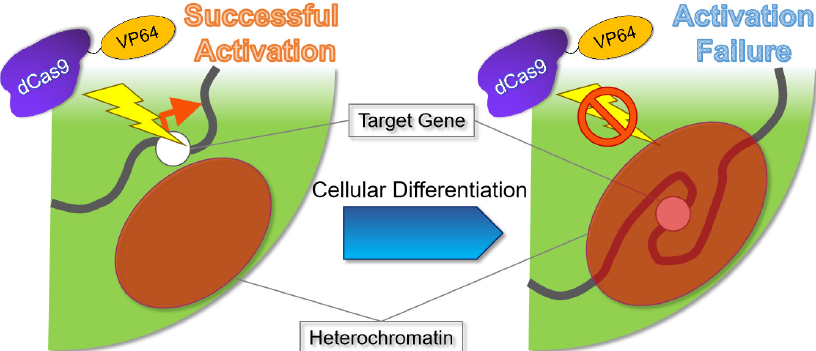
Figure 3. Schematic illustration of the importance of the chromatin structure in epigenome editing. During cell differentiation, the cell nucleus (light green) forms a heterochromatin (red) [137,138,141]. If the target gene is located within the heterochromatic region, it is inaccessible for expression (right panel). Dead Cas9 (dCas9)-four tandem repeats of the transcriptional activator VP16 (VP64) (dCas9-VP64) is shown as an example of an epigenomic-modifying enzyme.